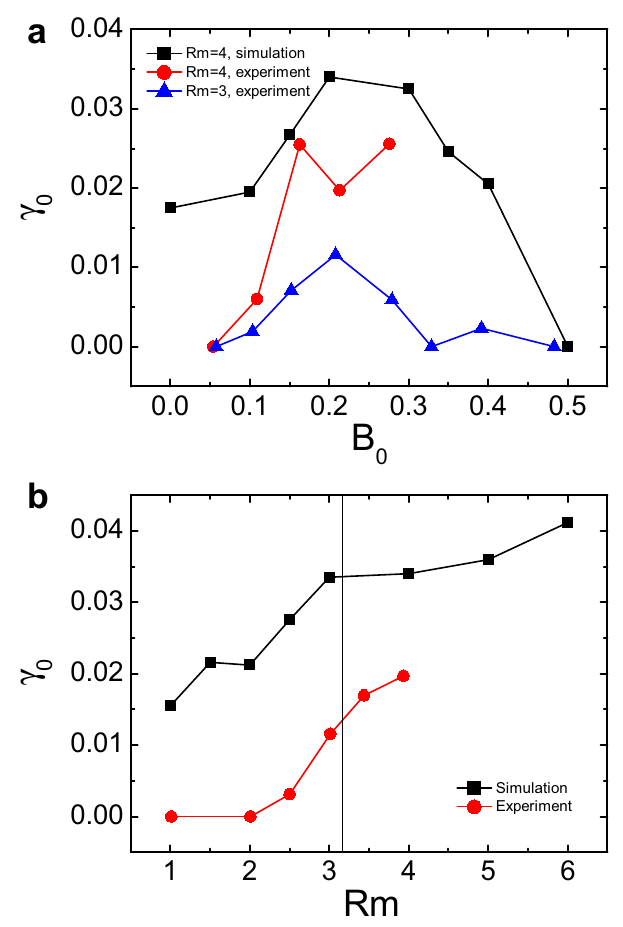
Fig. 5 | Comparison of the m =1 mode growth rate in simulation and experi- ment. a Normalized growth rate γ 0 of the m =1 mode from the 2-mode simulation (blacksquares)and theexperiment(redcirclesand bluetriangles),asafunctionof B fi xed Rm. b Corresponding γ fi xed B 0 at a 0 as a function of Rm at 0